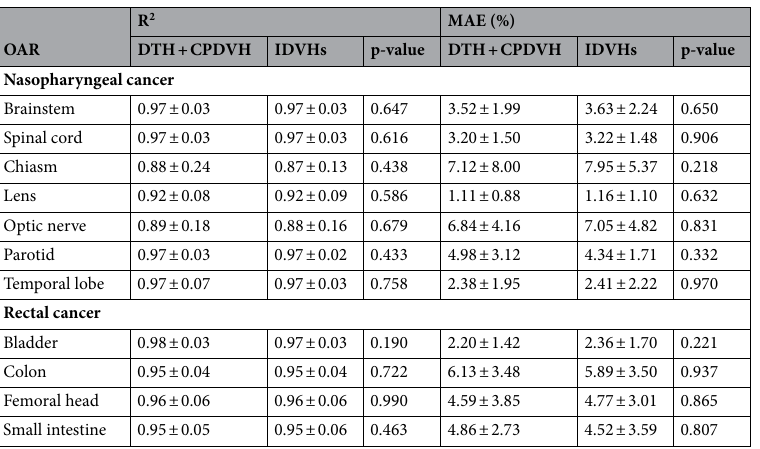
Table 3. The means and standard deviations of R 2 and MAE of the DTH + CPDVH method and IDVHs method for 20 nasopharyngeal cancer patients and 15 rectal cancer patients. The p-value between the DTH + CPDVH method and the IDVH method was given, and the difference was considered statistically significant if the p-value was less than